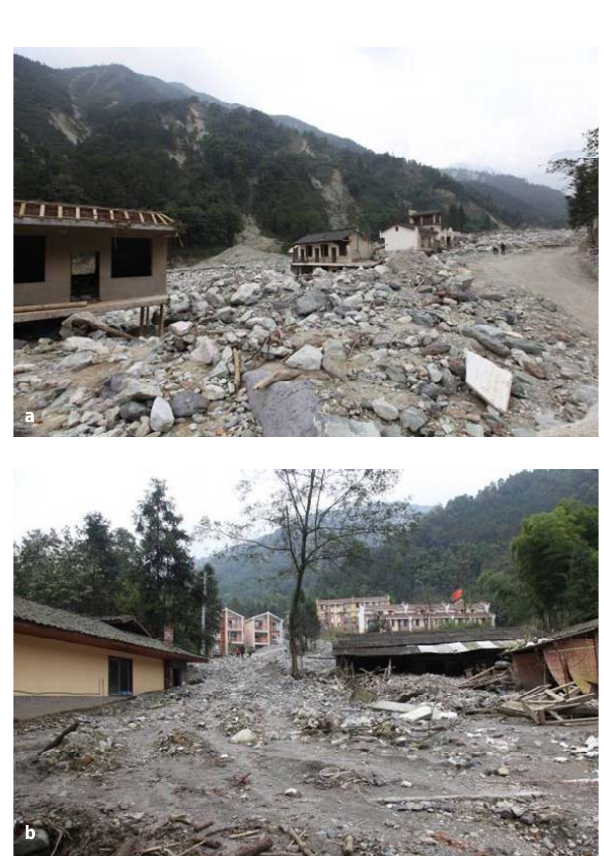
Fig. 16. Residential housing destroyed by the 8.13 Longchi debris flow in the Longxi catchment (a: the housing located along the Longxi river destroyed by the debris flow; b: the housing located at the right side of Longxi river destroyed by the debris flow).